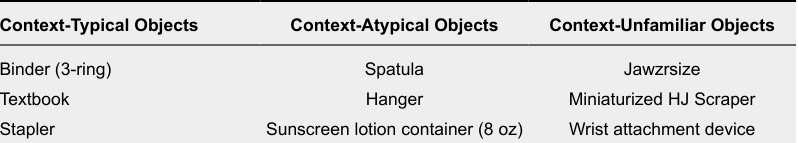
Description of the Objects Used in Experiment 3